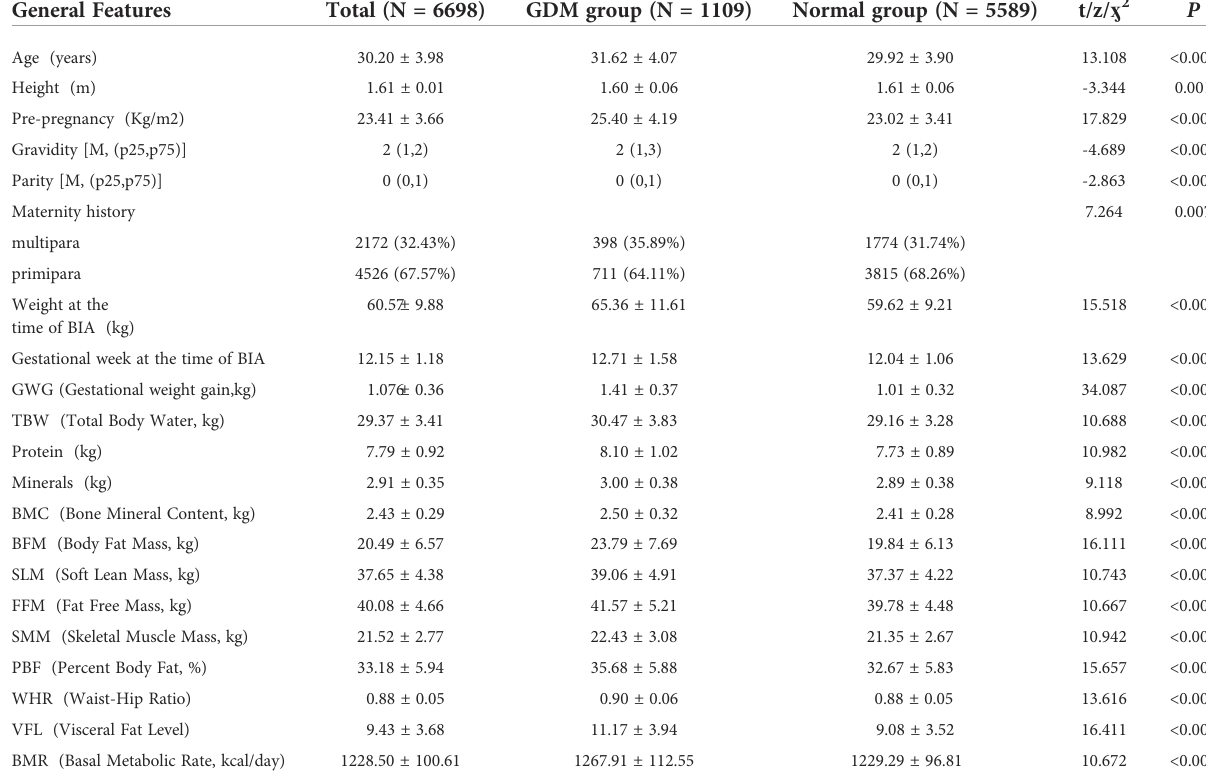
TABLE 1 Basic characteristics of pregnant women.